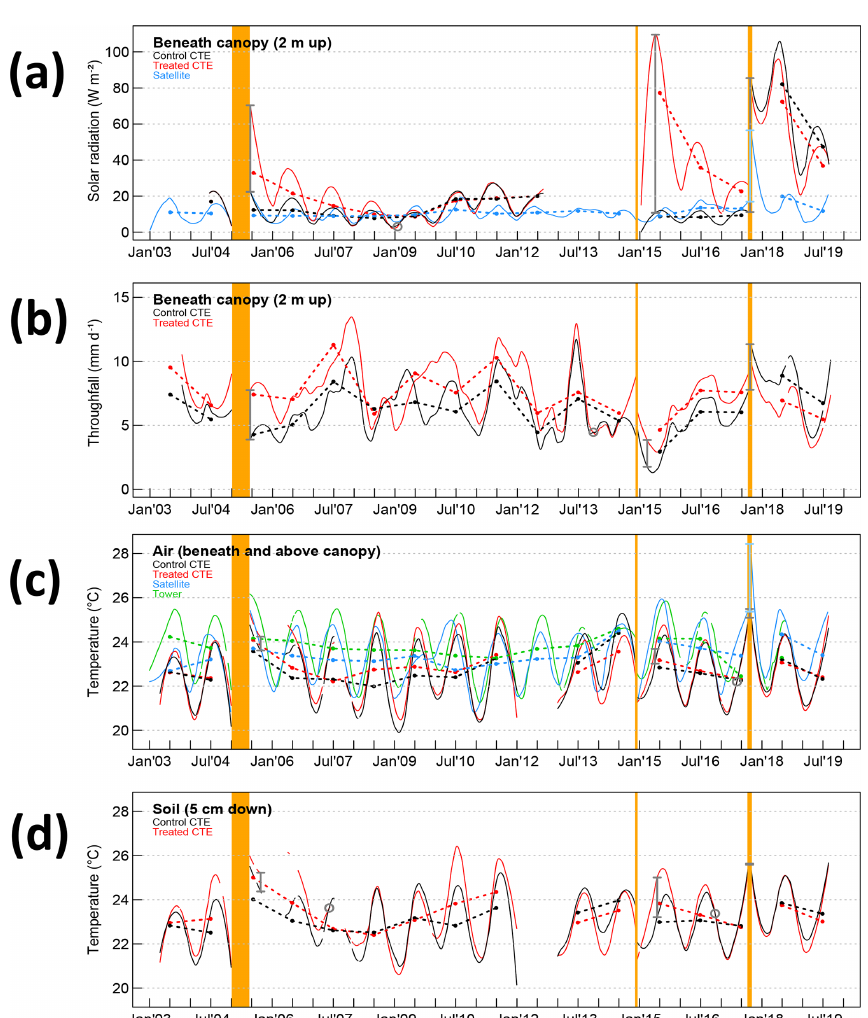
Figure 1. Primary factor time series, or factors that change due to the initial disturbance changes. Orange vertical lines are the periods of Canopy Trimming Experiment (CTE) 1, CTE2, and hurricanes Irma and Maria (appear as one line), sequentially. Daily values of data are represented with fitted smoothed lines, and thick dotted dashed lines connect annual averages of daily data to aid in visualization of the differences between the time series. Red lines are from treated areas and black lines are from control areas (until the hurricanes) beneath the canopy. Green lines are from the tower weather station above the CTE control canopy, and blue lines are from satellite data. Vertical bars show the acute change after an event for CTE data (gray) and satellite data (blue). The time of recovery from each experiment calculated from the smooth data (if seen) is marked with a gray circle. Plots show (a) solar radiation beneath the canopy, (b) throughfall, (c) air temperature, and (d) soil